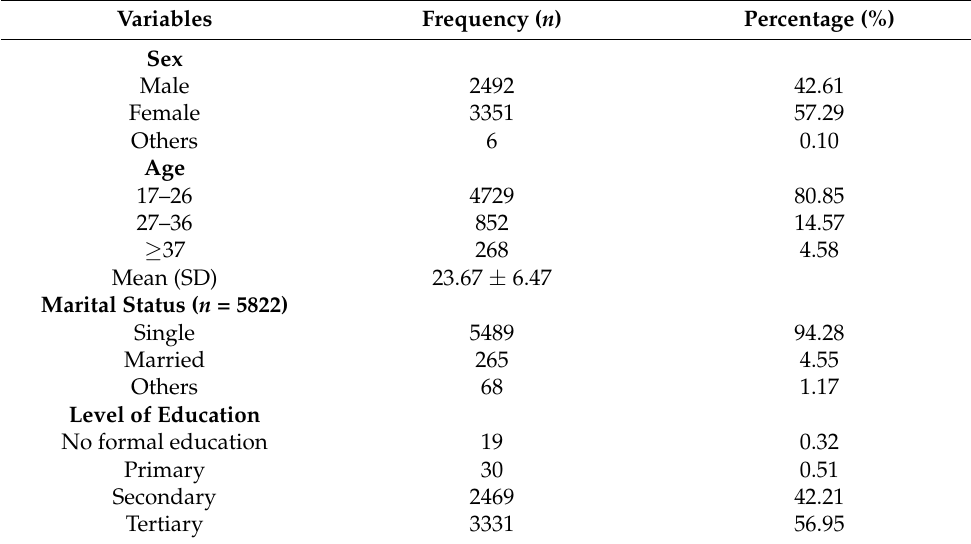
Table 1. Demographics of participants ( n = 5849).